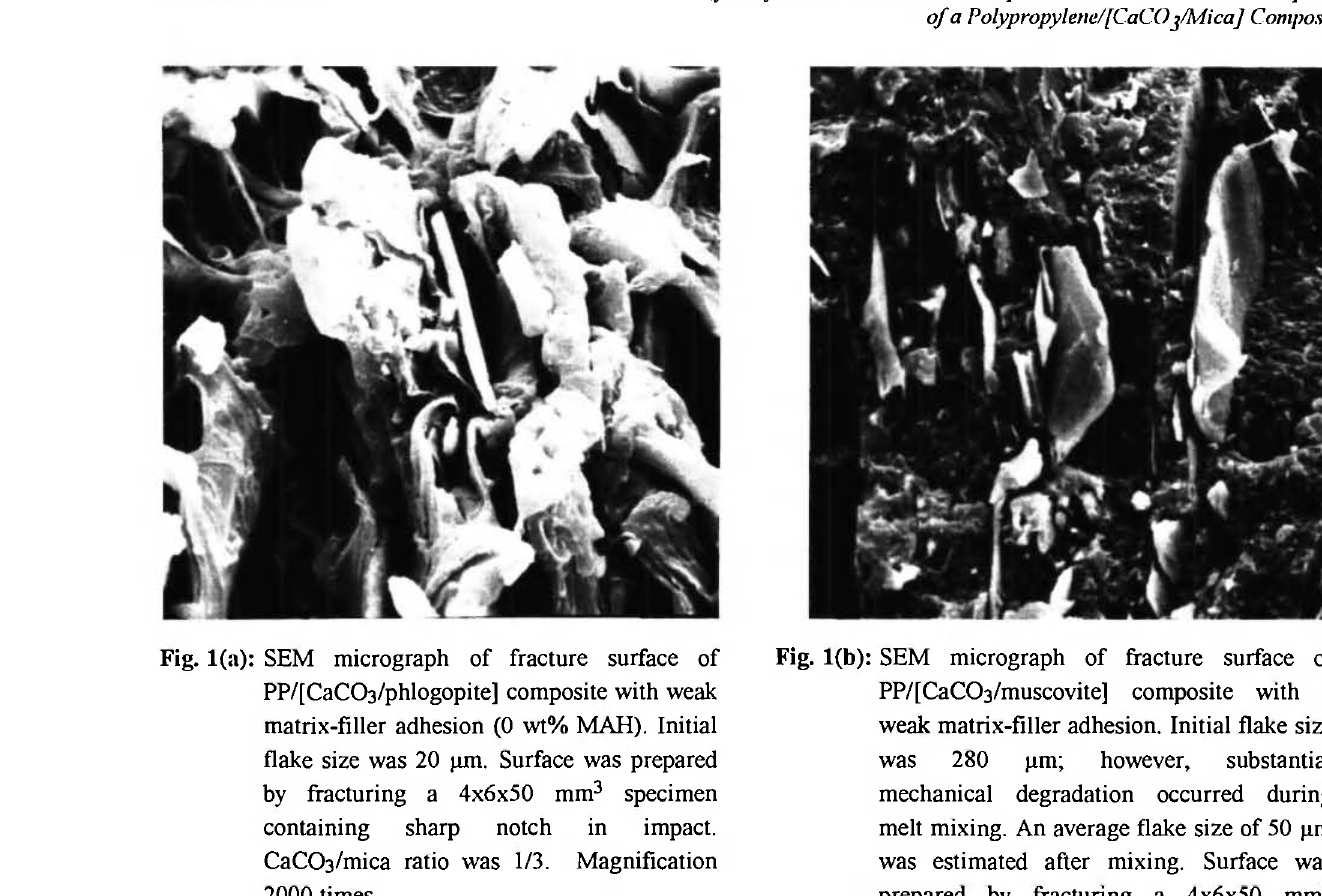
Fig. 1(a): SEM micrograph of fracture surface of PP/[CaC03/phlogopite] composite with weak matrix-filler adhesion (0 wt% ΜΑΗ). Initial flake size was 20 μτη. Surface was prepared by fracturing a 4x6x50 mm 3 specimen containing sharp notch in impact. CaC03/mica ratio was 1/3. Magnification 2000 times.